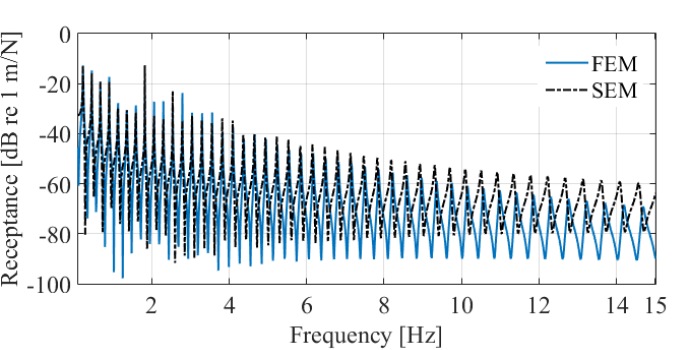
Figure 11. Cable receptance obtained at the left end via SEM and FEM.